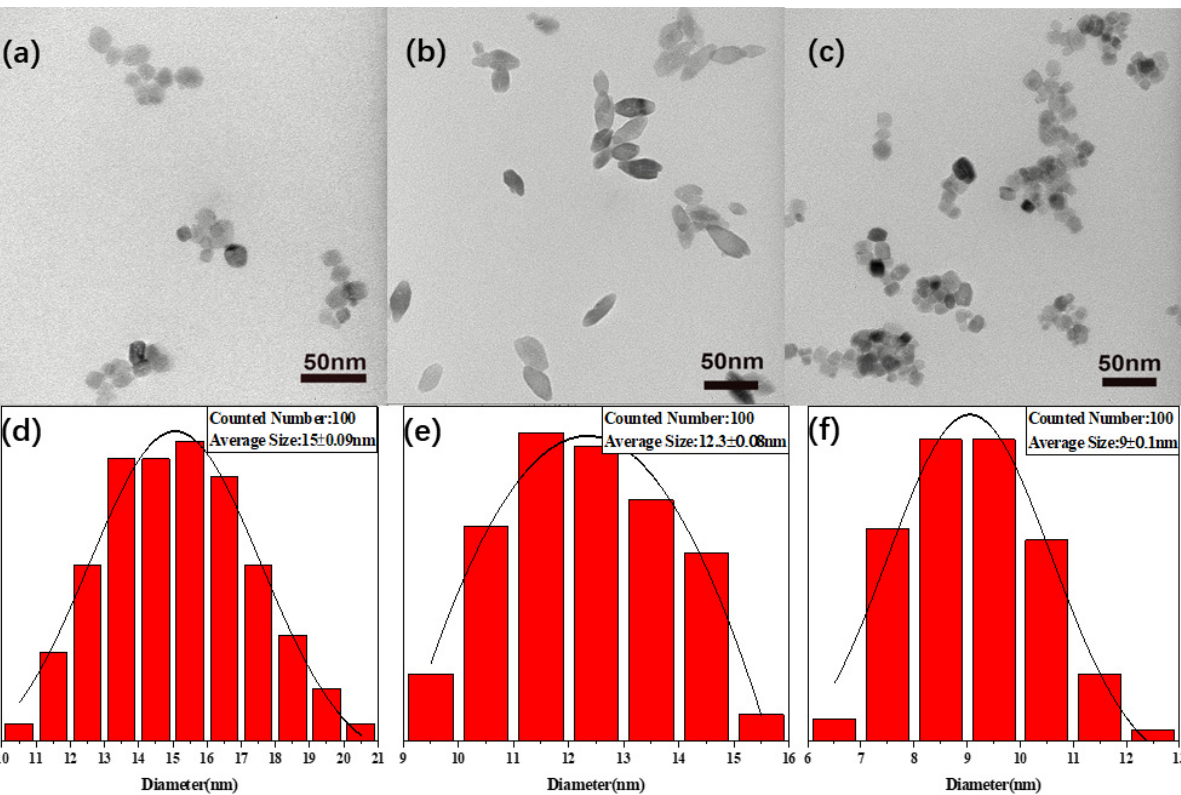
Figure 3. TEM images of ( a ) TiO 2 ( b ) TiO 2 ‐ Eu 3+ ( c ) TiO 2 ‐ ETP and diameter distribution histograms of ( d ) TiO 2 , ( e ) TiO 2 ‐ Eu 3+ , ( f ) TiO 2 ‐ ETP.